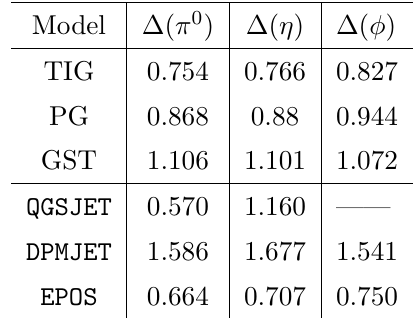
Table 1 . Comparison of meson production rate using different hadronic interaction models. Numer- ical values of ∆ , the relative integrated production rate of a given meson, for the various cosmic ray models (top three rows) and hadronic interaction models (bottom three rows) considered in this